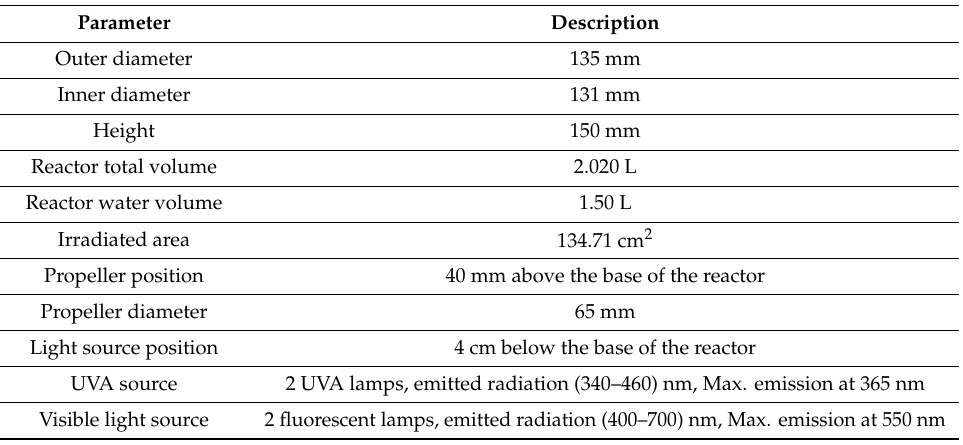
Figure 1. Schematic representation of the Stirred Tank Reactor (STR). Table 2. Stirred tank reactor dimensions and specifications.